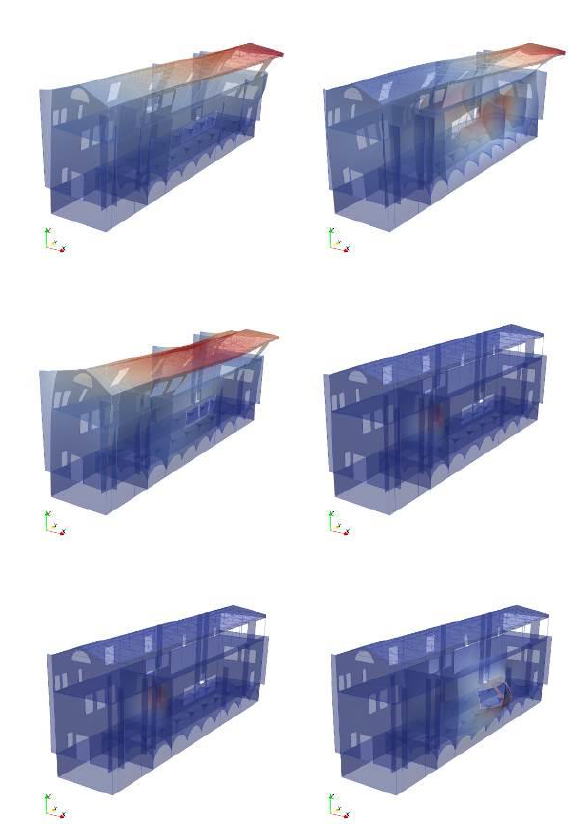
Figure 6. First 2 modal shapes for different in aggregate restraint conditions (from isolated to fully